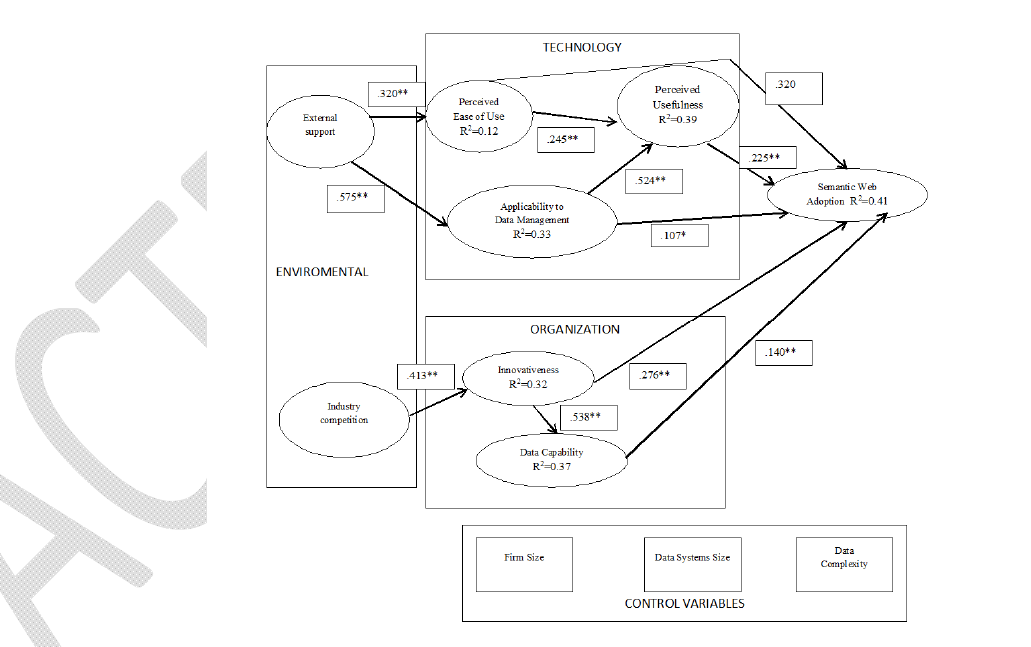
Fig. 3. The Result of Structure Model